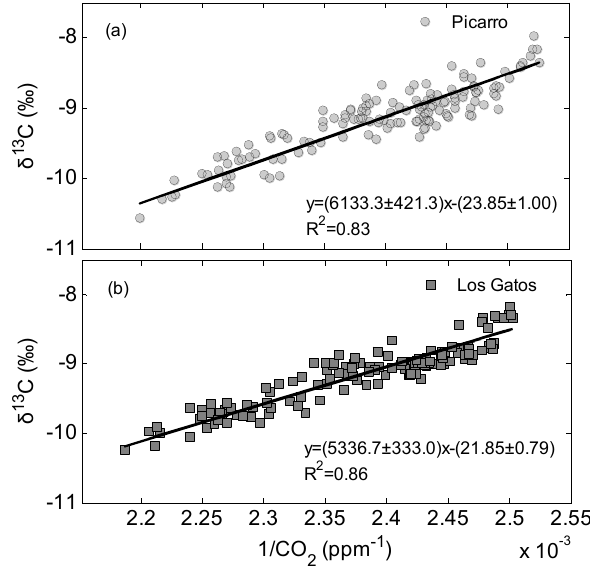
Fig. 6. Keeling plot of the calibrated atmospheric δ 13 C against the reciprocal of the calibrated CO 2 concentration for (a) the Picarro G1101-i and (b) the Los Gatos DLT-100 analyzer. Both daytime and nighttime data were used. Calibration was made with Method